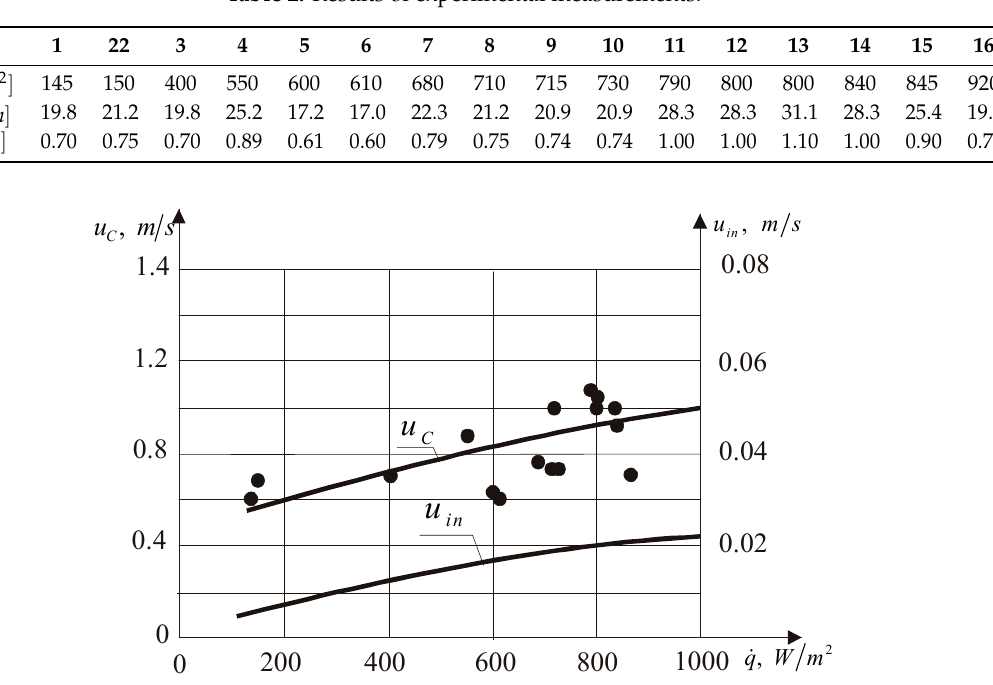
Figure 7. Comparison between the experimental and theoretical results.